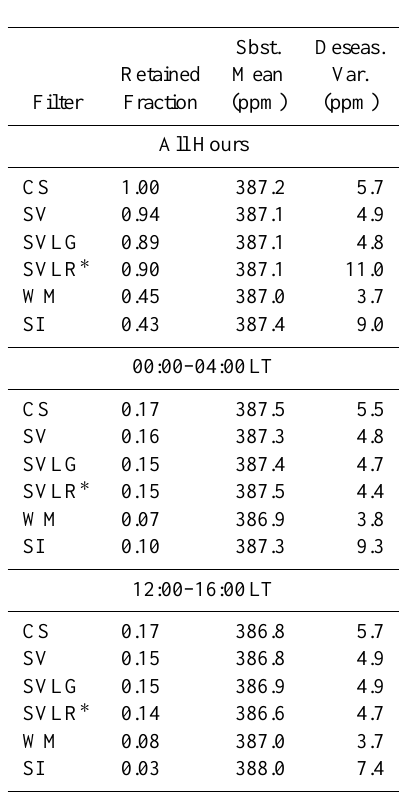
Table 2. Filter statistics for the complete set (CS) and each subset (SV, SVLG, SVLR, WM, SI) representing four RACCOON sites HDP, NWR, RBA and SPL (asterisk indicates SVLR statistics ex- clude HDP data). The retained fraction is computed as the propor- tion of observations remaining after filtering. Subset means repre- sent the average subset value, and deseasonalized variability indi- cates the average variability for each subset after removing the sea- sonal cycle. The topmost sub-table compares subsets when no time- of-day filtering is used, while the lower two sub-tables compare filtering methods when used in combination with time-of-day fil- tering. Nocturnal filtering targeting downward descending free tro- pospheric air during hours 00:00, 01:00, 02:00, 03:00LT (the half-